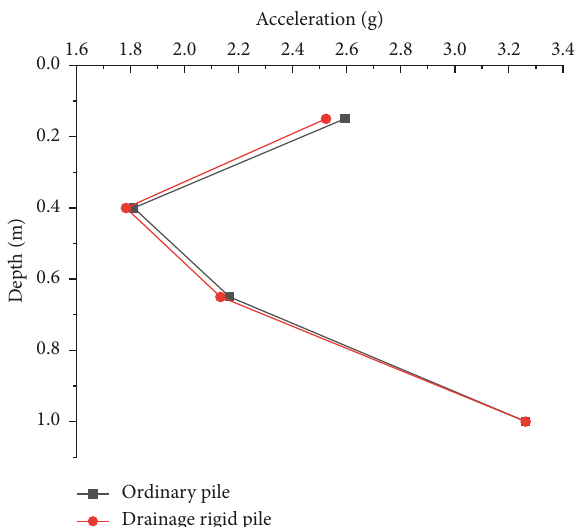
Figure 15: The variation pattern of peak vertical acceleration along the depth on both sides of the ordinary pile and the drainage rigid